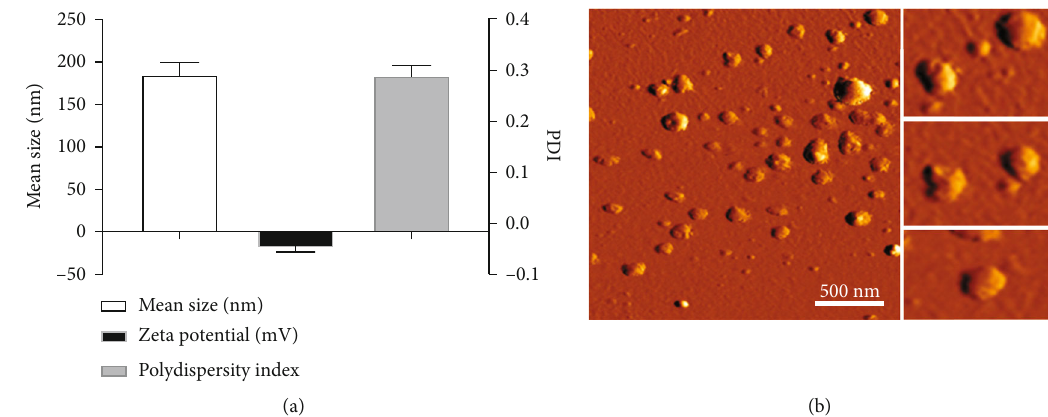
Figure 2: (a) Characteristics of the guttiferone E-loaded liposomes. (b) Atomic force microscopy (AFM) images of the size distribution and morphology of guttiferone E-loaded